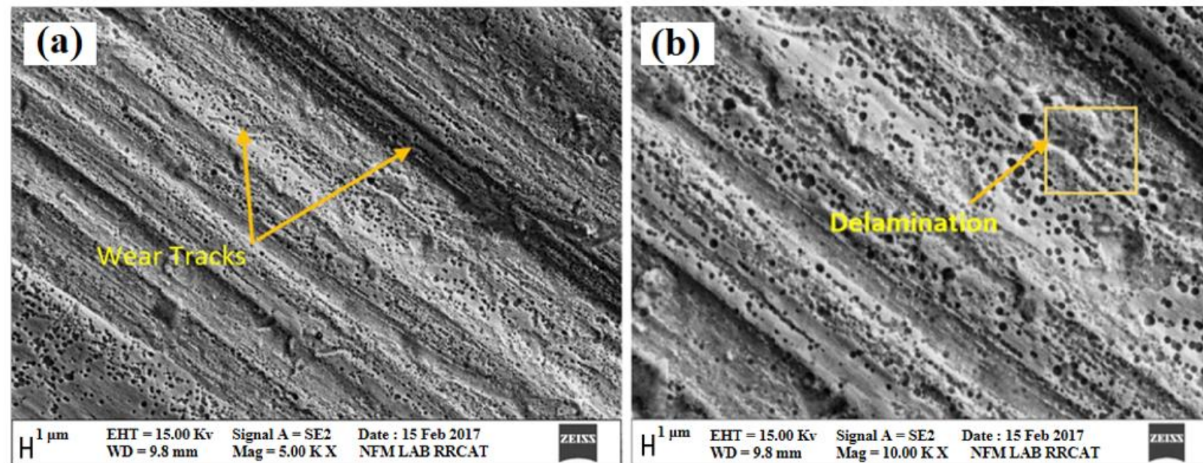
Figure 9. Schematic of a wear surface of an untreated sample. ( a ) lower magnification; ( b ) higher magnification. (Reprinted with permission from ref. [107]. Copyright 2019 Springer).